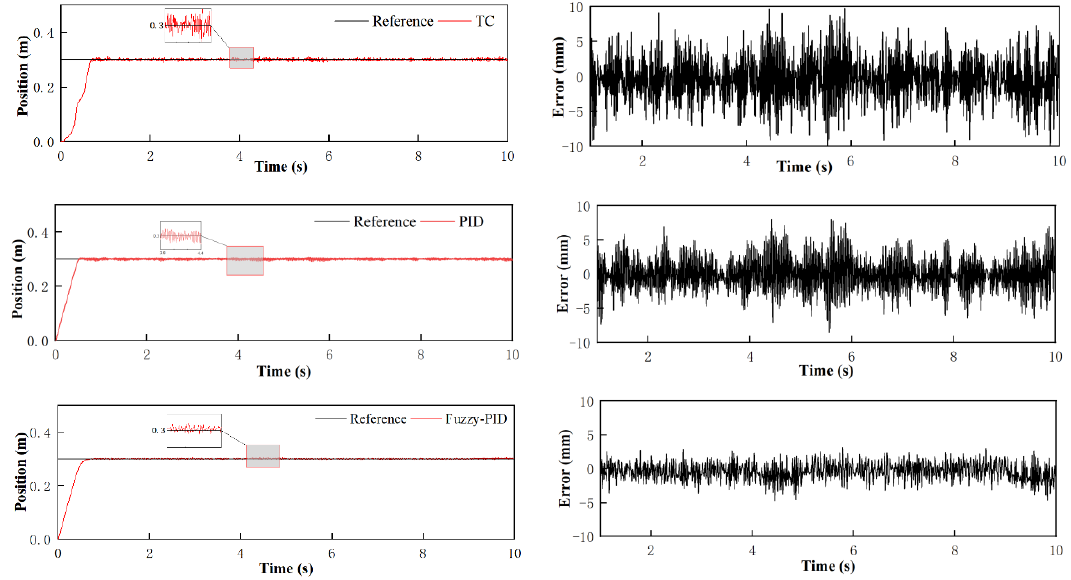
Figure 15. Experiments of unit step response characteristics.